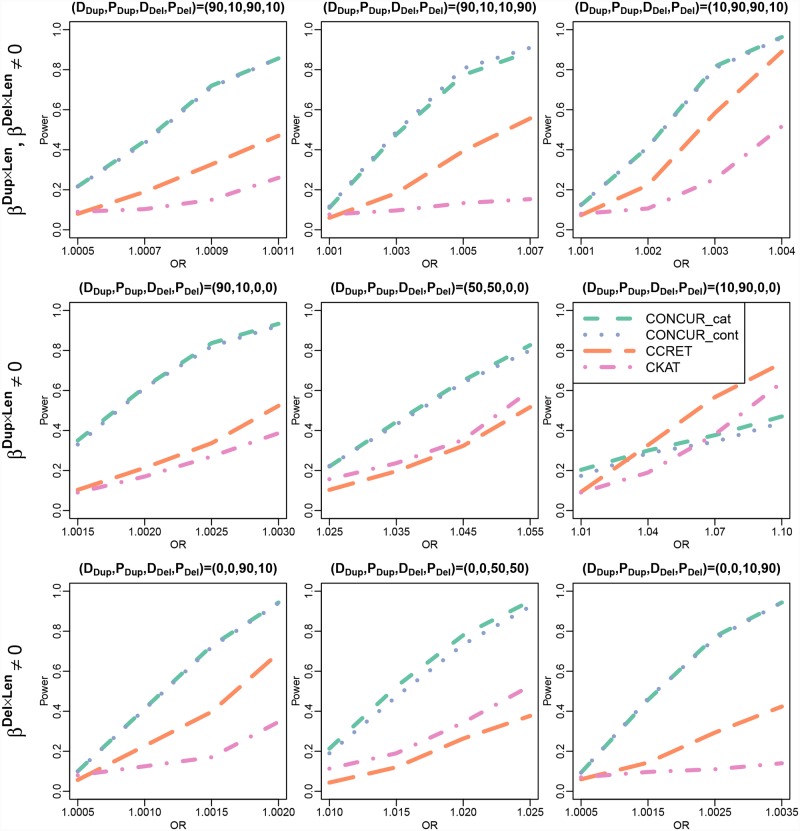
Power comparison between CONCUR, CCRET, and CKAT in TWB-Chr1(a) (causal continuous dosage × length effects in chromosome 1 of TWB data).The top panel shows power under combined duplication and deletion effects, the middle panel shows power under effects from duplications only, and the bottom panel shows power under effects from deletions only. Different proportions of deleterious vs. protective effects are considered as indicated by (DDup,PDup,DDel,PDel) with DDup and PDup reflecting the proportions of deleterious and protective segments among causal duplication segments, and with DDel and PDel defined similarly for causal deletion segments.